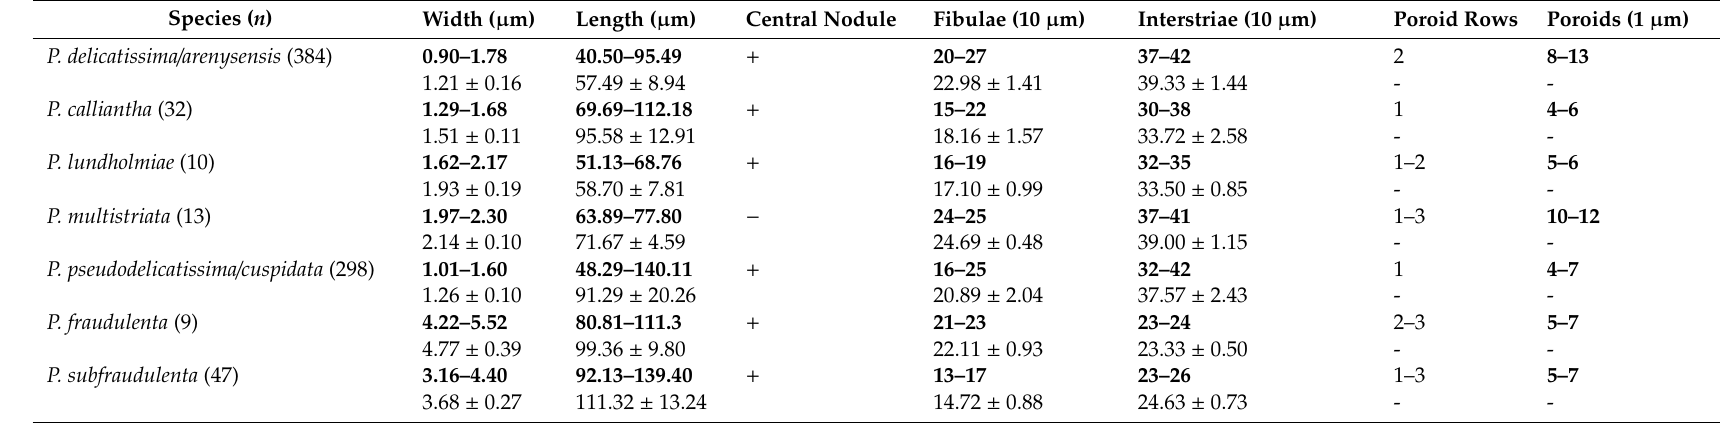
Table 1. Morphological features of the Pseudo-nitzschia species obtained by SEM. The numbers of cells measured are given in parentheses ( n ); minimum and maximum values are given in bold, while the average ± standard deviation is specified